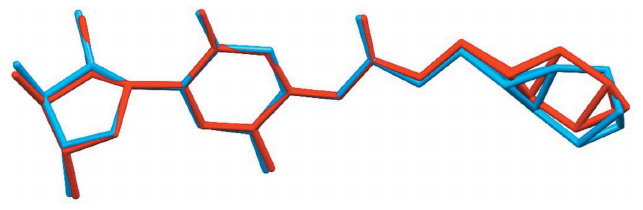
Figure 1 Overlay of the capecitabine molecular structures arising from powder diffraction (blue) and from single-crystal diffraction data (red). Only non- H atoms are shown for clarity.